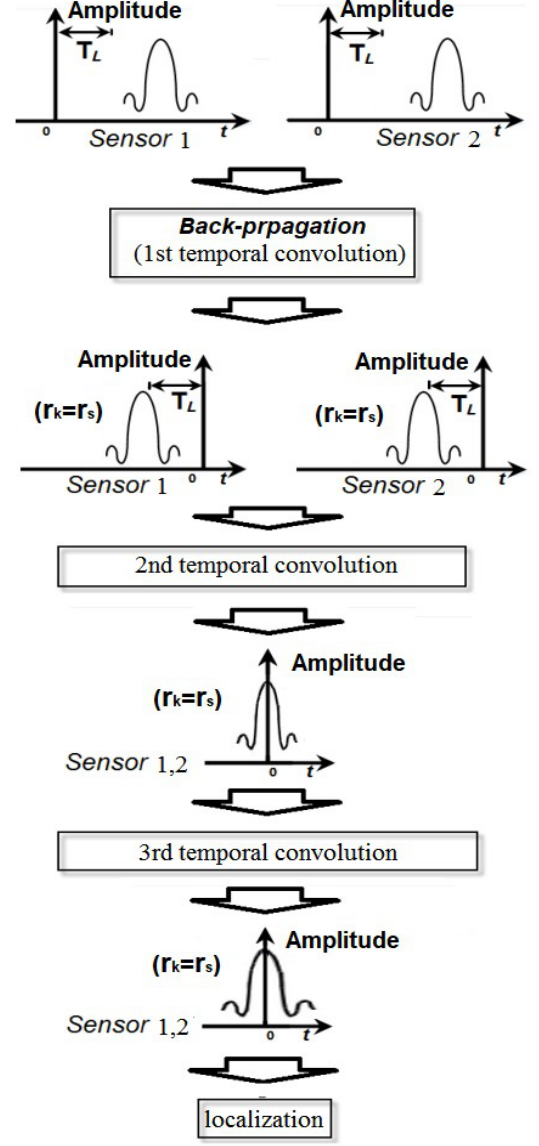
Figure 2. The flow diagram of the proposed algorithm.